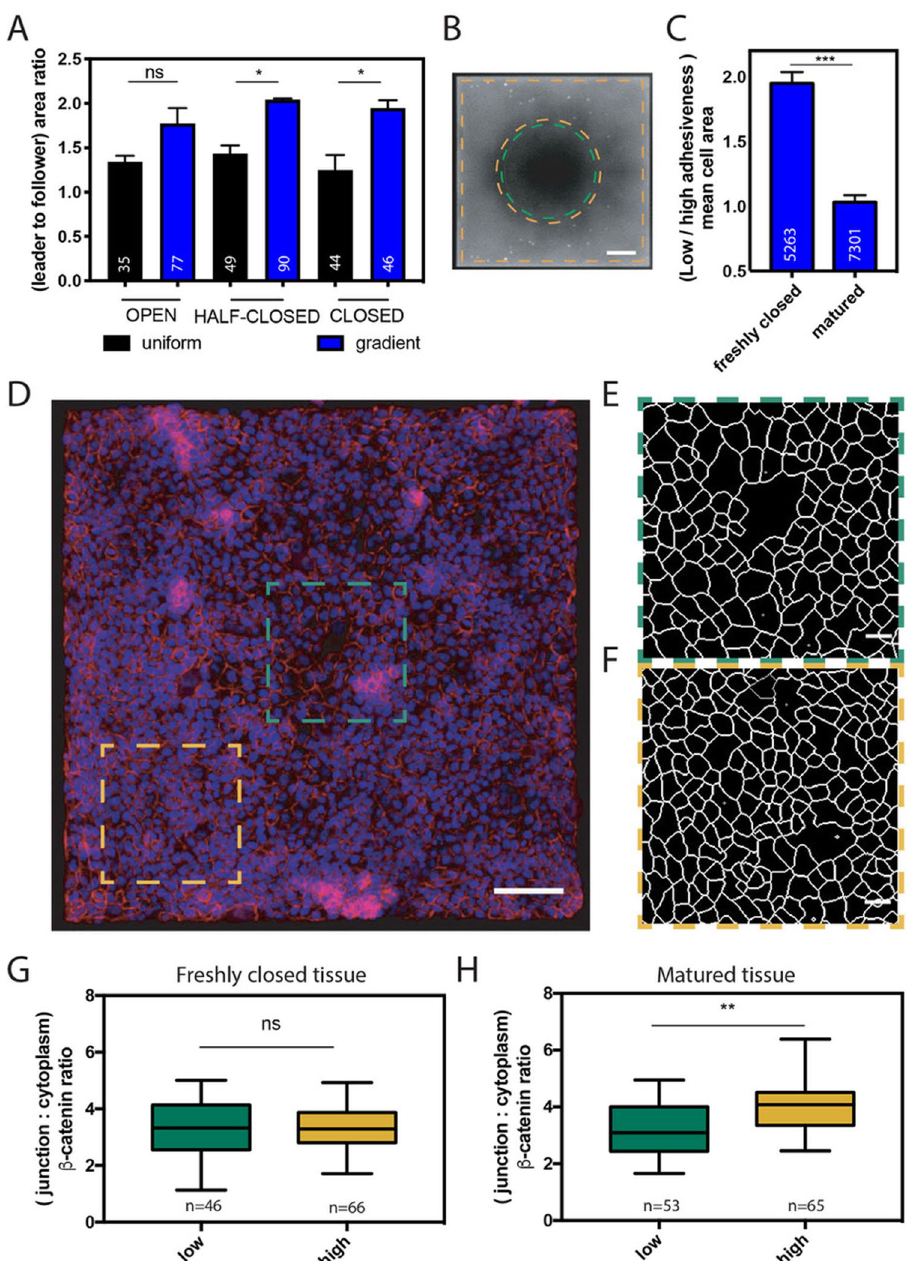
Figure 2. Gap closure on a gradient of FN requires more cell spreading and leads to weaker cell–cell contacts. ( A ) Ratio of the cell area between leader and follower cells during a gap closure on a uniform FN coating (density ~ 1 µg/cm 2 in black) and a FN gradient (in blue). ( B ) The FN pattern was divided in two zones: high FN density zone (from 384 ± 10 down to 118 ± 8 ng/cm 2 ) at the periphery (in orange) and a low FN density zone (from 118 ± 8 down to 32 ± 6 ng/cm 2 ) at the center (in green). ( C ) Ratio of the cell areas on low FN density zone (from 118 ± 8 down to 32 ± 6 ng/cm 2 ) versus high FN density zone (from 384 ± 10 down to 118 ± 8 ng/cm 2 ). Cell areas were measured at t = 3 h (freshly closed tissue, n = 3) and t = 36 h (matured tissue, n = 4) after gap closure. ( D ) Fluorescent image of a gap freshly closed over a FN gradient. Nuclei were labelled in blue with DAPI and β-catenin was labelled in red. The scale bar is 100 µm. Segmentation of the cell–cell junctions in epithelial tissues over ( E ) low (FN density from 118 ± 8 down to 32 ± 6 ng/cm 2 ) and ( F ) high (FN density from 384 ± 10 down to 118 ± 8 ng/cm 2 ) FN zones. The scale bars are 20 µm. ( G and H ) Ratio of the fluorescence intensity of β-catenin between cell–cell junctions and cytoplasmic zones of cells grown on low (FN density from 118 ± 8 down to 32 ± 6 ng/cm 2 , in green, n = 2) and high (FN density from 384 ± 10 down to 118 ± 8 ng/cm 2 , in orange, n = 2) FN zones for epithelial monolayers ( G ) freshly closed or ( H ) matured over a FN